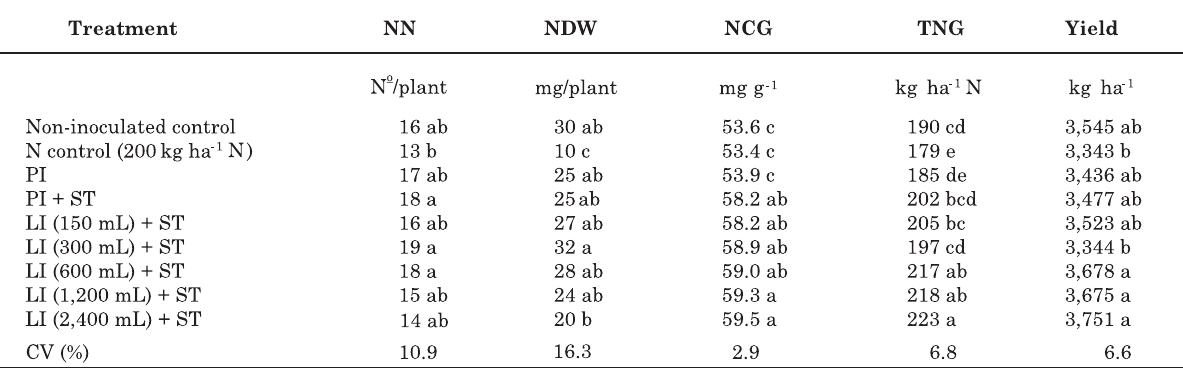
(1) Peat inoculant was applied to the seed surface, according to the standard inoculation for the growing season, resulting in 300,000 cells seed -1 ; liquid inoculant was sprayed into the planting furrow at 150 (300,000 cells seed -1 ), 300, 600, 1200, and 2400 mL ha -1 , in a final volume of 50 L ha -1 (inoculant + water). Fungicides and micronutrients are described in the Materials and Methods section. (2) Means (n = 6) in the same column followed by different letters are significantly different (p ≤ 0.05, Fisher LSD